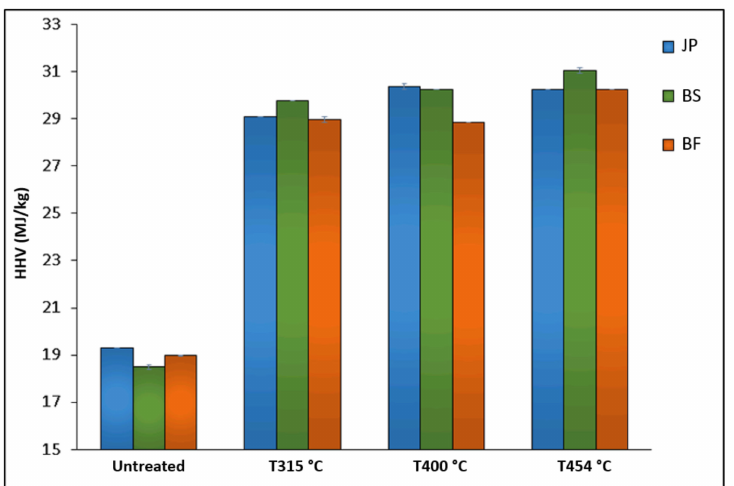
Figure 7. Higher heating value of pellets derived from untreated- and treated-wood pellets derived from the three species: JP, BS, and